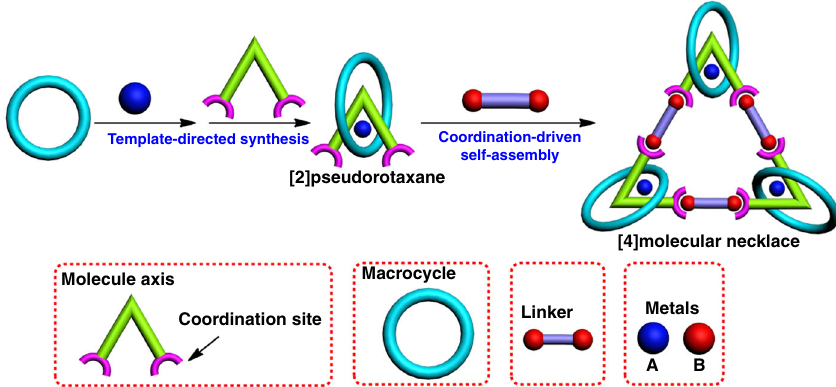
Fig. 1 The concept of molecular necklace design. The cartoon presents the “ threading-followed-by-ring-closing ” approach for construction of heterometallic triangular